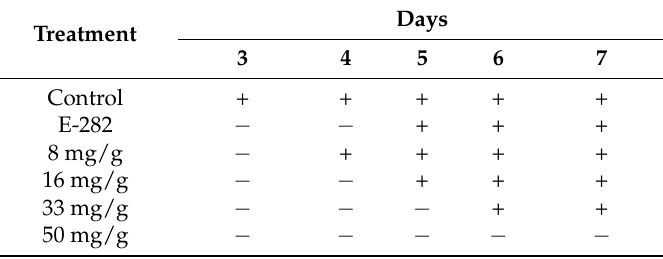
Table 2. The shelf life of pita bread, stored in a plastic tray, contaminated with P. verrucosum and treated with 8, 16, 33 and 50 mg/g of oriental mustard flour sauce, in comparison to the control experiment and the pita bread treated with the preservative compound